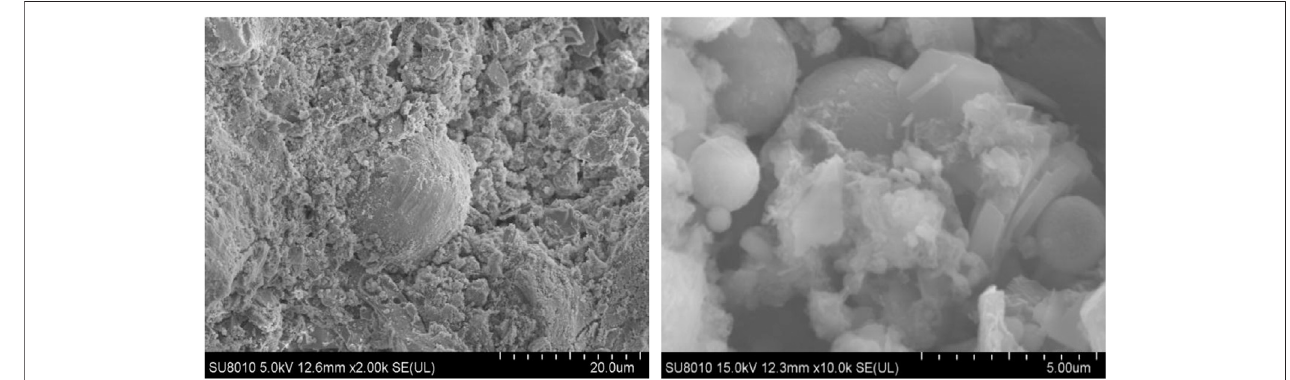
FIGURE 8 | SEM images of dissolved fl y ash.